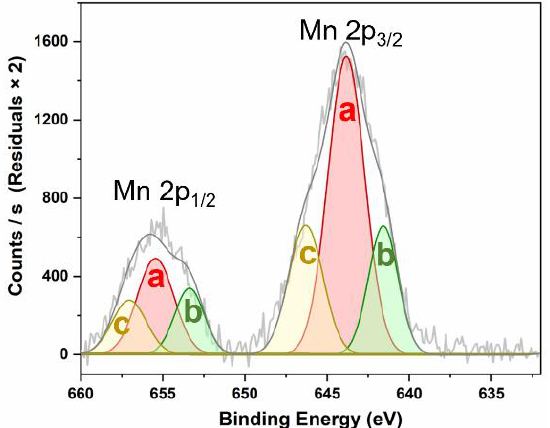
Figure 7. XPS Mn2p spectrum of the Mn-nanozyme. Its deconvolution allowed identifying Mn in different oxidation states: ( a ) Mn 3+ , ( b ) Mn 2+ , and ( c ) Mn 4+ .